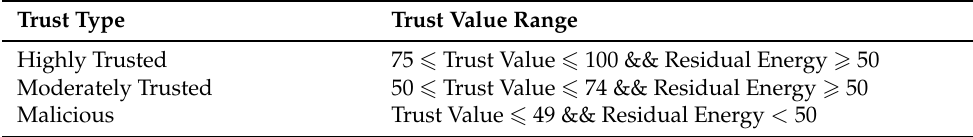
Table 1. Classes of device